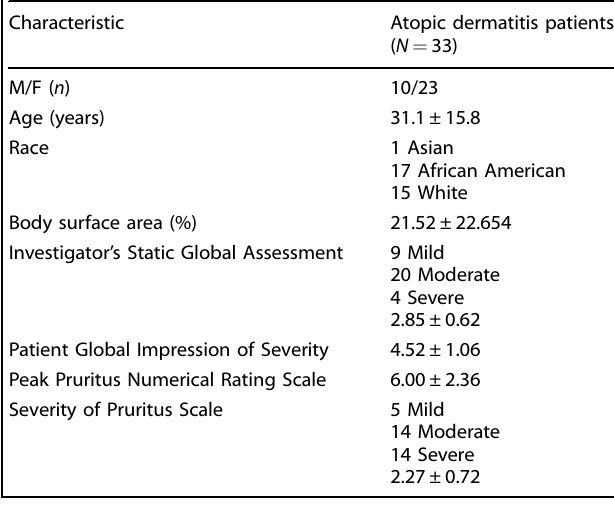
Table 1. Characteristics of participants used for analysis.